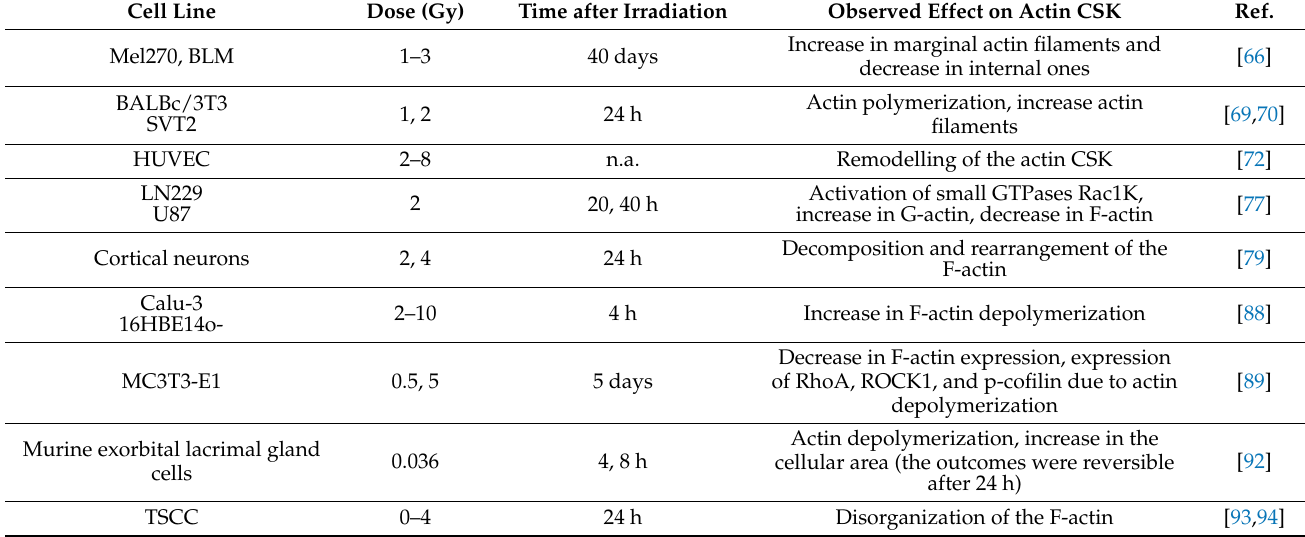
Table 1. Effects of radiation on actin